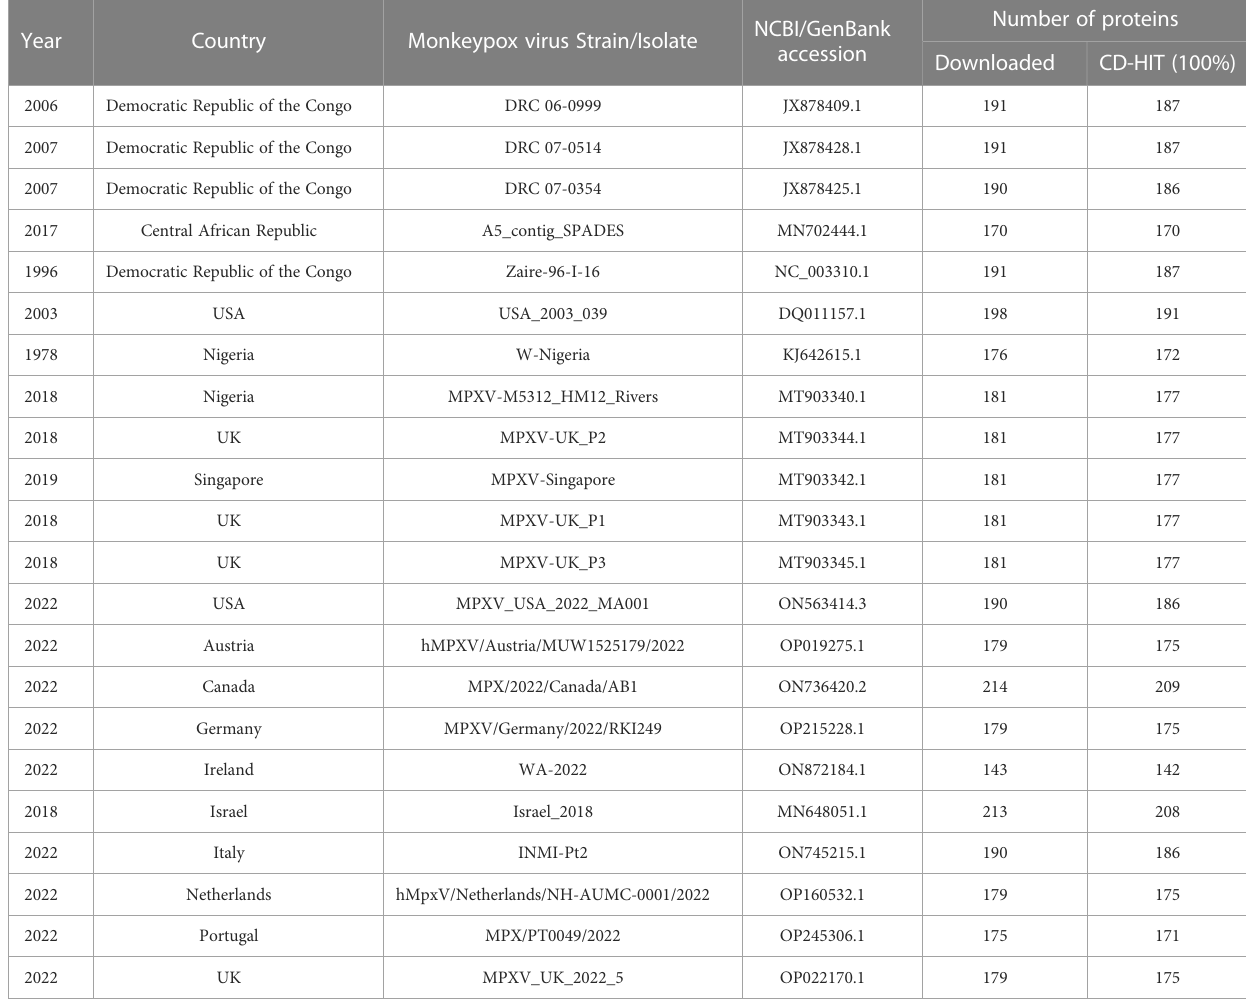
TABLE 1 Detailed information of the monkeypox virus strains